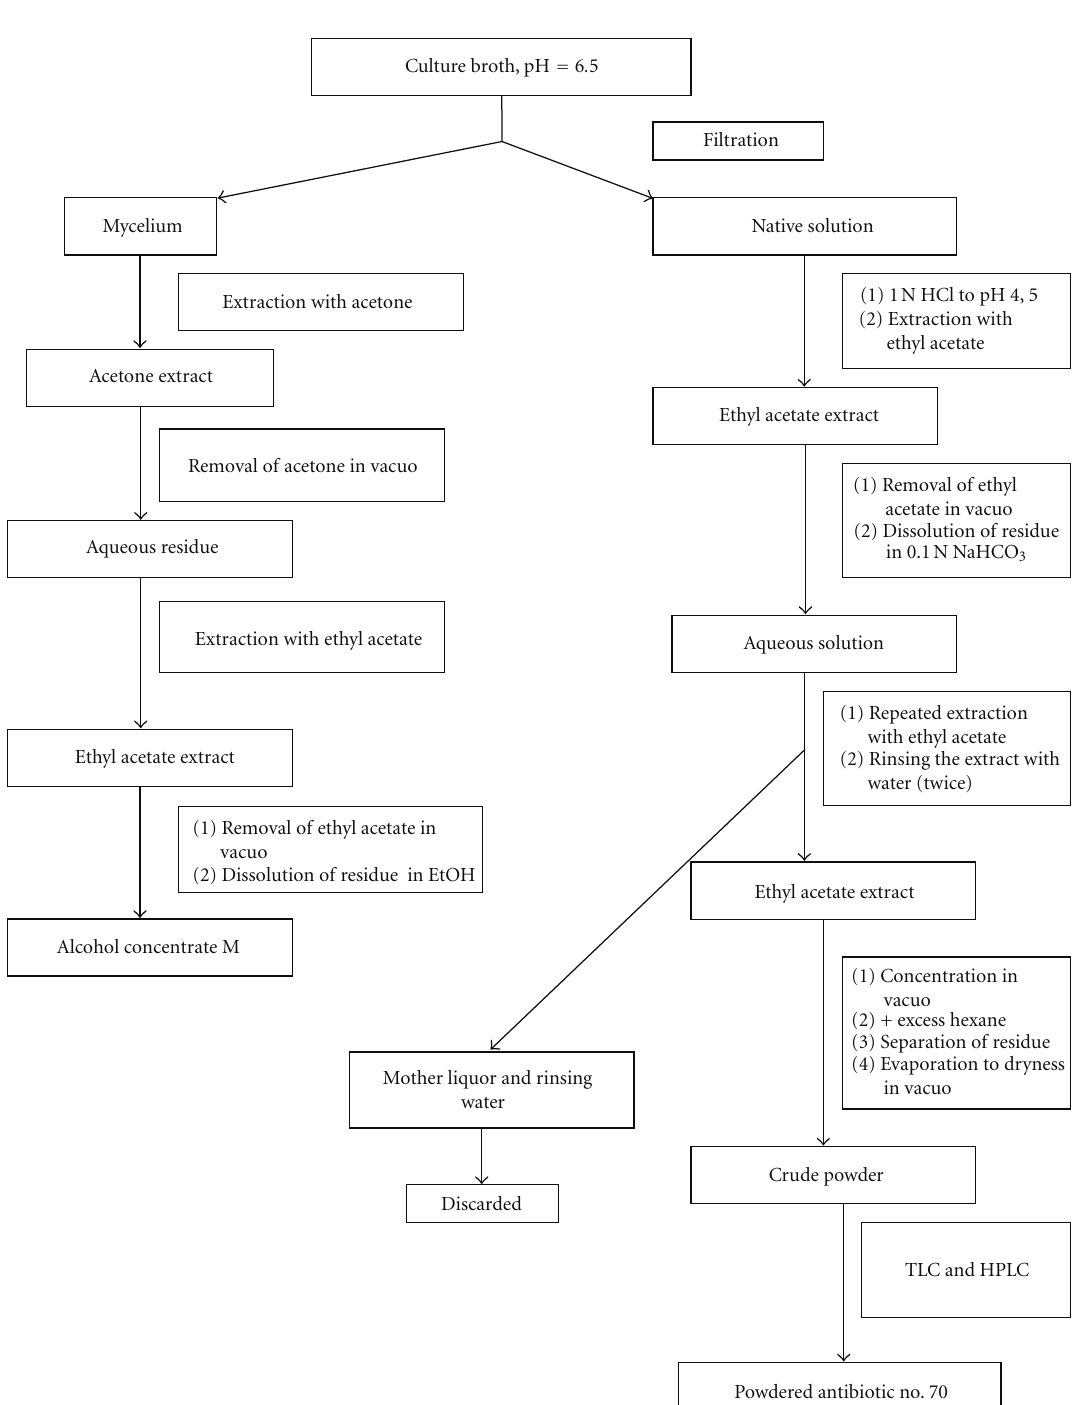
Figure 1: Flowchart for isolation of antibiotic no. 70. Antibiotic no. 70 was isolated from culture broth of the producer IMV-70 by extraction methods. The flowchart for the extraction that produces the powder preparation of compound no. 70 is shown in Figure 1. The antibiotic no. 70 was isolated from culture broth by extraction with ethyl acetate, was subsequently purified from the inactive lipid fraction, and was extracted from the concentrated solution with